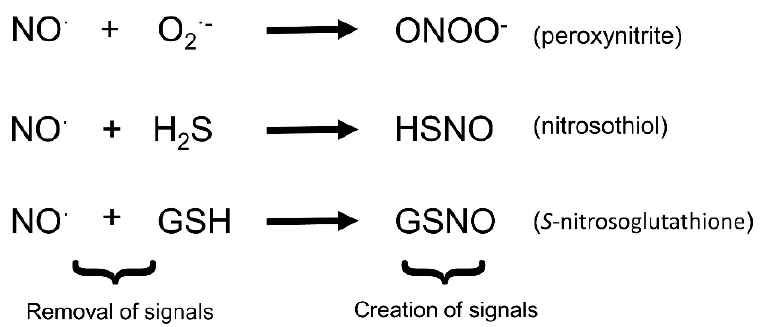
Figure 3. Some of the reactions in which NO can be involved, often leading to new signaling